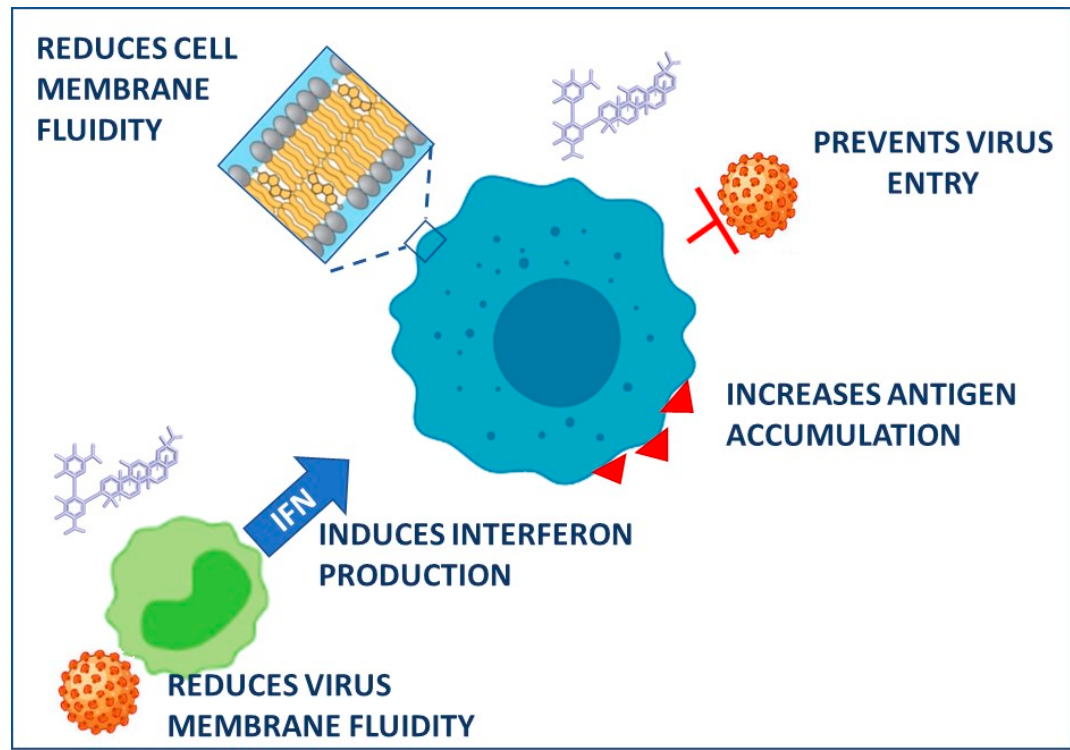
Figure 2. Proposed mechanisms in the antiviral effects of glycyrrhizin. Created with BioRender.com, accessed on 18 March